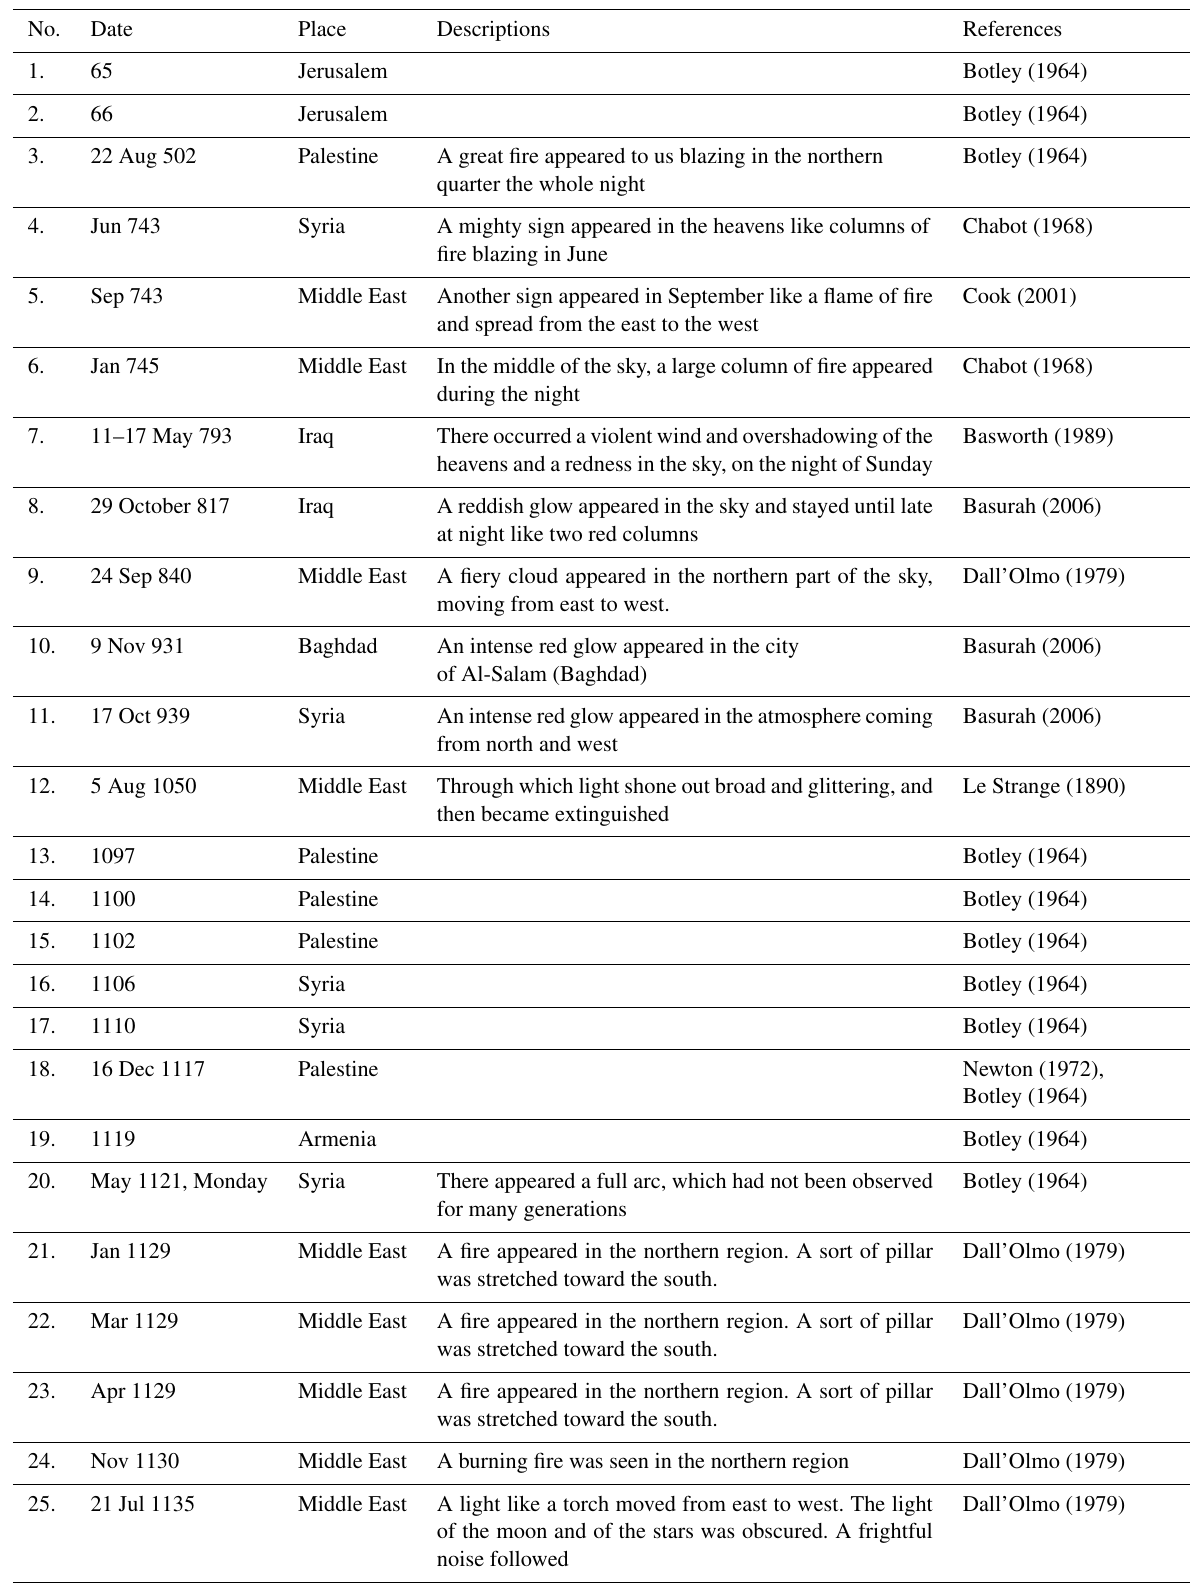
Table 4. Ancient aurora observations recorded in the Middle East region during the Medieval